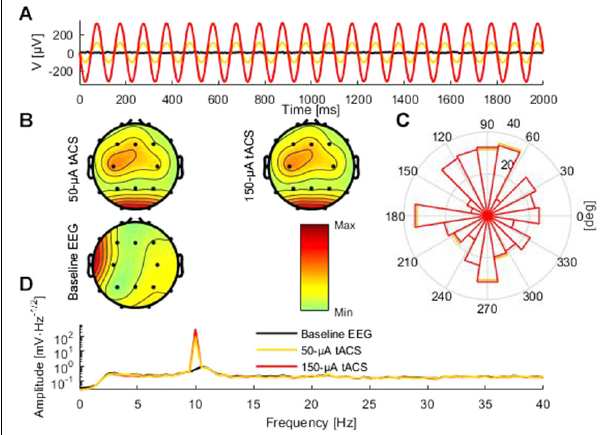
FIGURE 2 | Comparison of baseline data and tACS-contaminated data. (A) An illustrative 2-s segment of the baseline (black) and the artifactual data (red and yellow) measured at electrode Pz. (B) The topographies showing the average amplitude in the range 8–12 Hz of the artifactual and baseline data. (C) Circular histogram of the phase-difference distribution between the artifactual data and the baseline data at 10 Hz across all epochs and channels for the 50- µ A (yellow) and 150- µ A (red) condition. (D) Frequency spectra of the 50- µ A (yellow), 150- µ A (red), and baseline conditions (black). Because of the logarithmic scale the peak amplitudes at 10 Hz for the 50- µ A and 150- µ A conditions appear similar regardless of the threefold